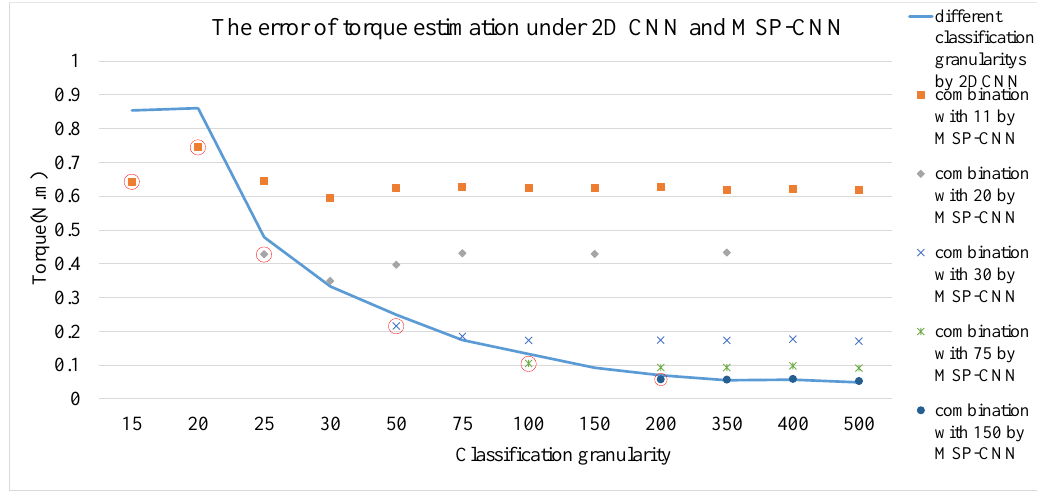
Figure 11. Torque estimation error under two-dimensional (2D CNN) and MSP-CNN.